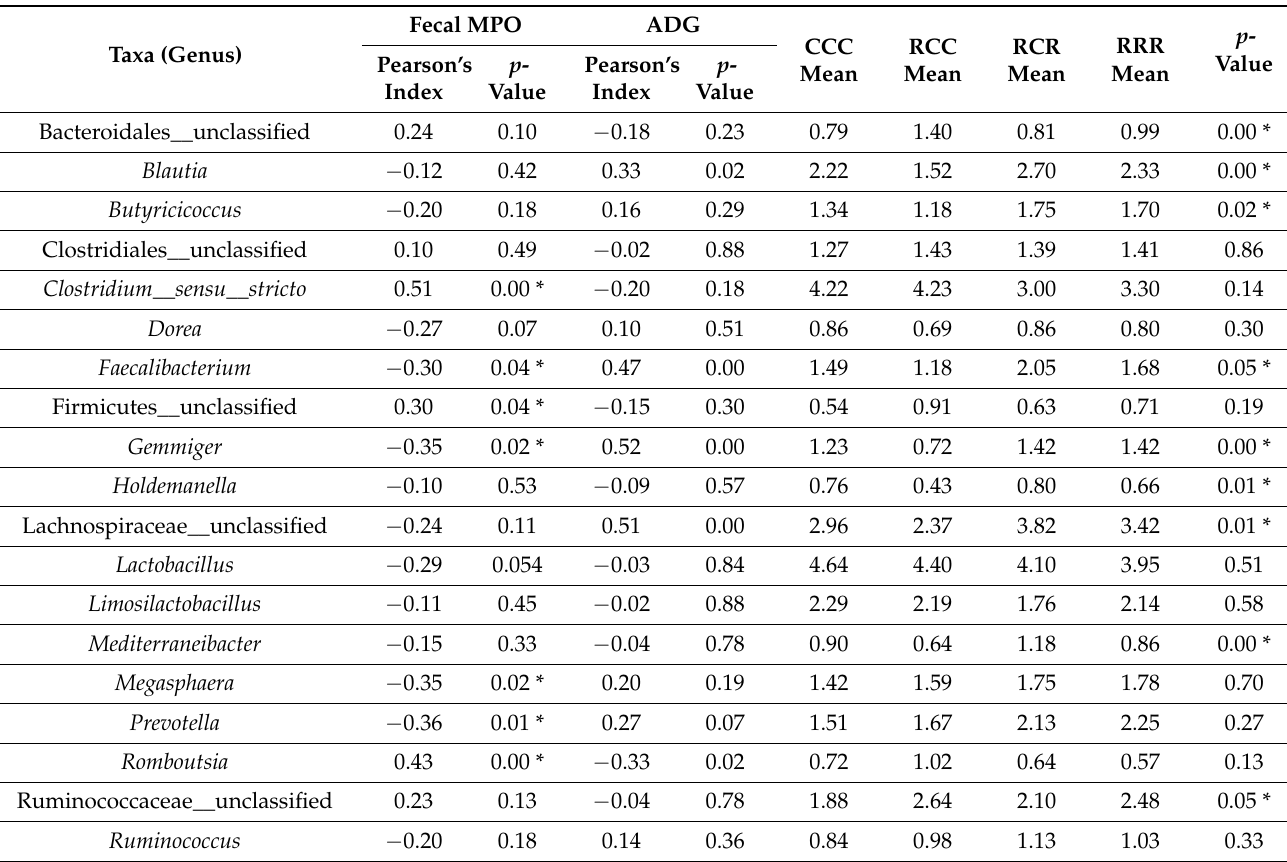
Table 4. Effects of RAC supplementation on top 20 genera, and correlation of genus with fecal MPO and ADG of post- weaning